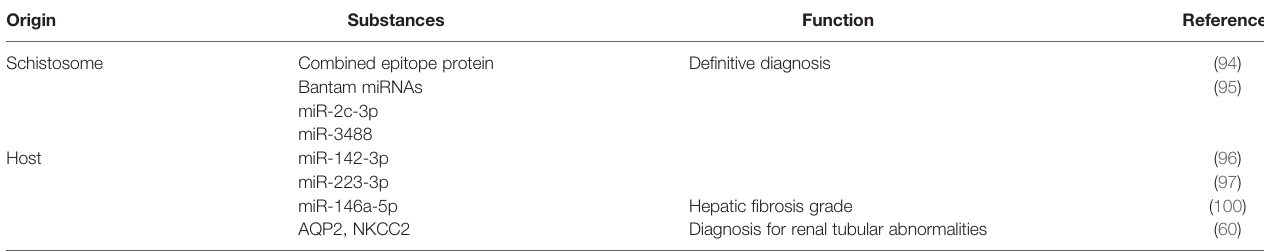
TABLE 2 | Exosomal substances from the serum of infected patients can be used as diagnostic tools in schistosomiasis.